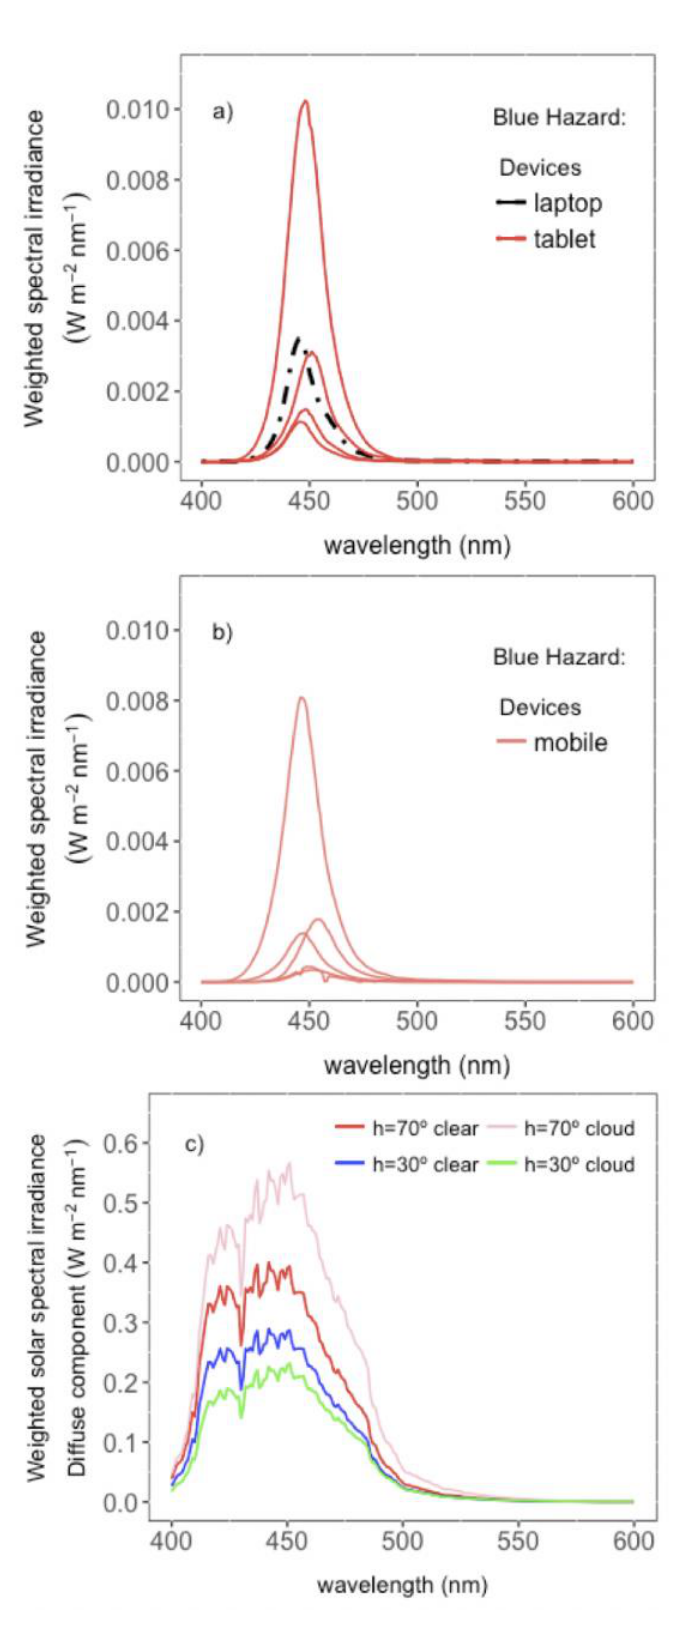
Figure 4. Weighted spectral irradiances for blue light hazard measured at 10 cm for different electronic devices: ( a ) one laptop and four electronic tablets; ( b ) five mobile phones; ( c ) solar diffuse spectral irradiance for blue light hazard on a horizontal plane at surface level, simulated with the Coupled Ocean–Atmosphere Radiative Transfer (COART) model for different altitude heights (h) and sky conditions.